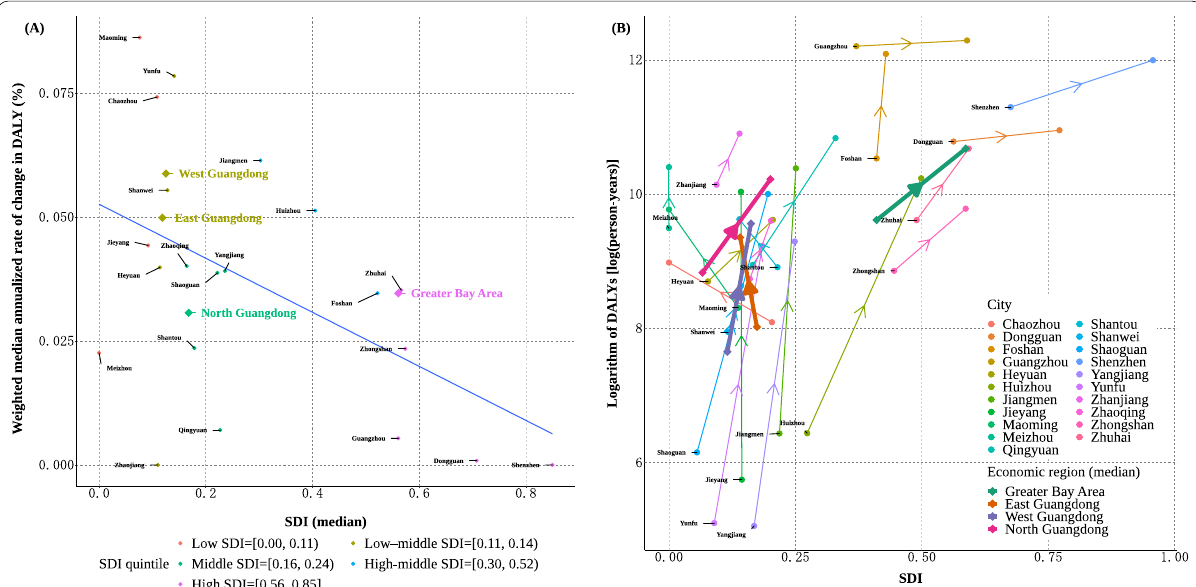
Fig. 1 Weighted median annualized rates of change ( a ) and change of logarithm of values ( b ) in disability-adjusted life-years (DALYs) for patients with severe mental disorders in Guangdong, China, during 2010–2020, by SDI group. Notes: SDI Socio-demographic Index. SDI groups were = generated by calculating quintiles at the set of percentiles p {0, 0.2, 0.4, 0.6, 0.8, 1.0}, in which five categories of SDI were yielded (namely, low = SDI < 0.11, Low-middle SDI < 0.14, Middle SDI < 0.24, high-middle SDI < 0.52, and High SDI 0.56). In ( a ), the median of SDI during 2010–2020 was ≥ plotted, whereas the blue line reflects the linear relationship between estimated SDI and weighted median annualized rates of change in DALYs ascribed to severe mental disorders. In ( b ), the logarithm of DALYs across 21 prefecture cities was further aggregated by the median for the four economic regions. Arrows indicate the direction of change in the logarithm of DALY, where comorbidity-adjusted values were